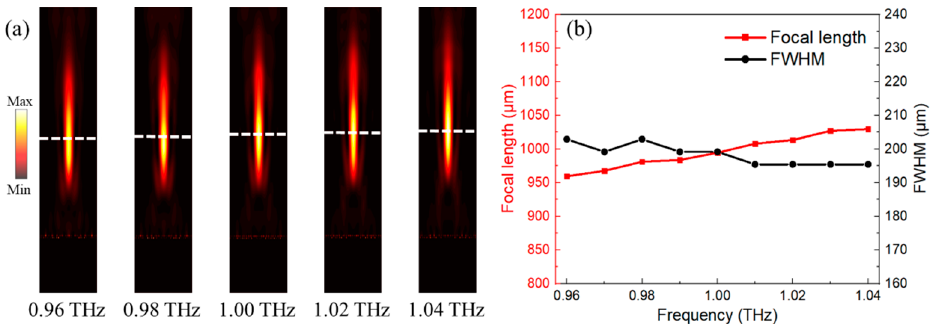
Figure 9. ( a ) The electrical field of cross-polarized waves in x - z plane from 0.96 THz to 1.04 THz. ( b ) The focal length and FWHM of the point focusing from 0.96 THz to 1.04 THz.